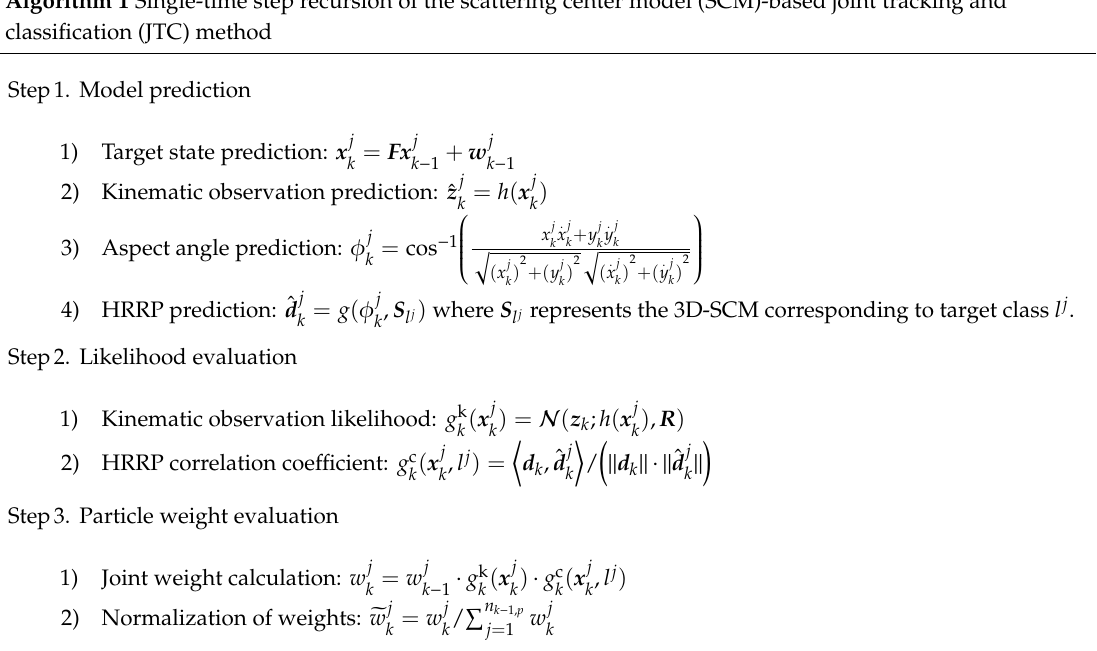
Algorithm 1 Single-time step recursion of the scattering center model (SCM)-based joint tracking